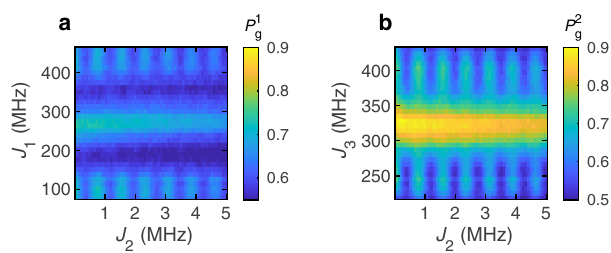
Fig. 3 Absence of Floquet enhancement due to the omission of a π pulse. a , b Measured ground-state return probabilities of ( a ) ST qubit 1 and ( b ) ST qubit 2, after four Floquet steps, with interaction time τ = 1.4 μ s. The ranges of J 1 and J 3 center around J π and J 2 π , respectively. The values of J 1 and J 3 are 1 3 swept simultaneously. The data are averaged over 8192 realizations.